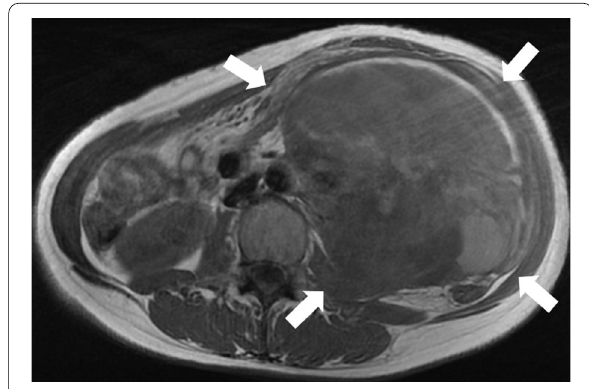
Fig. 1 The tumor, with a maximum size of 13 the left lateral abdomen (arrow). The tumor is uniformly high-intensity with partial low intensity on T2-weighted image